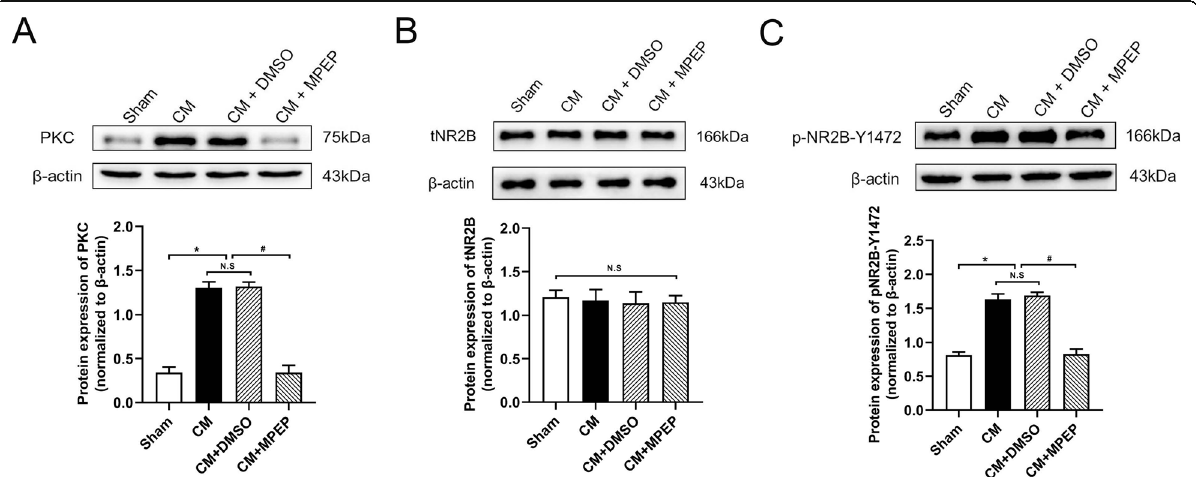
Fig. 7 The effect of MPEP on the expression of PKC and phosphorylation of NR2B at Tyr1472. Compared with the sham group, the expression of PKC and phosphorylation of NR2B at Tyr1472 increased in the CM group. There were no significant differences between the CM and CM + DMSO groups. The administration of MPEP significantly downregulated their expression. a The protein expression of PKC. b The protein expression of total NR2B. c The protein expression of phosphorylation of NR2B at Tyr1472. (n = 4 in each group; *p < 0.05 compared with the sham group; # p < 0.05 compared with the CM + DMSO group; N. S:p > 0.05 between two